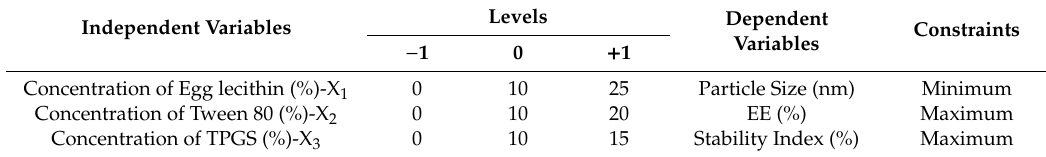
Table 1. Formulation parameters for